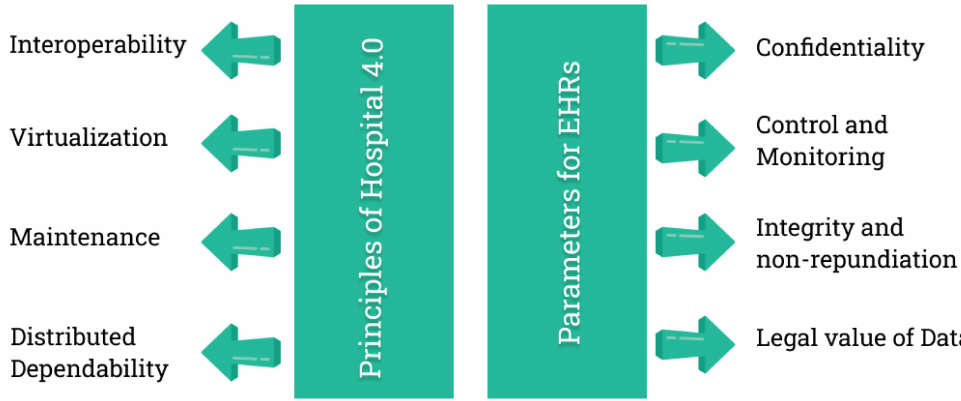
Figure 7. Principles of Hospital 4.0 and parameters for EHRs